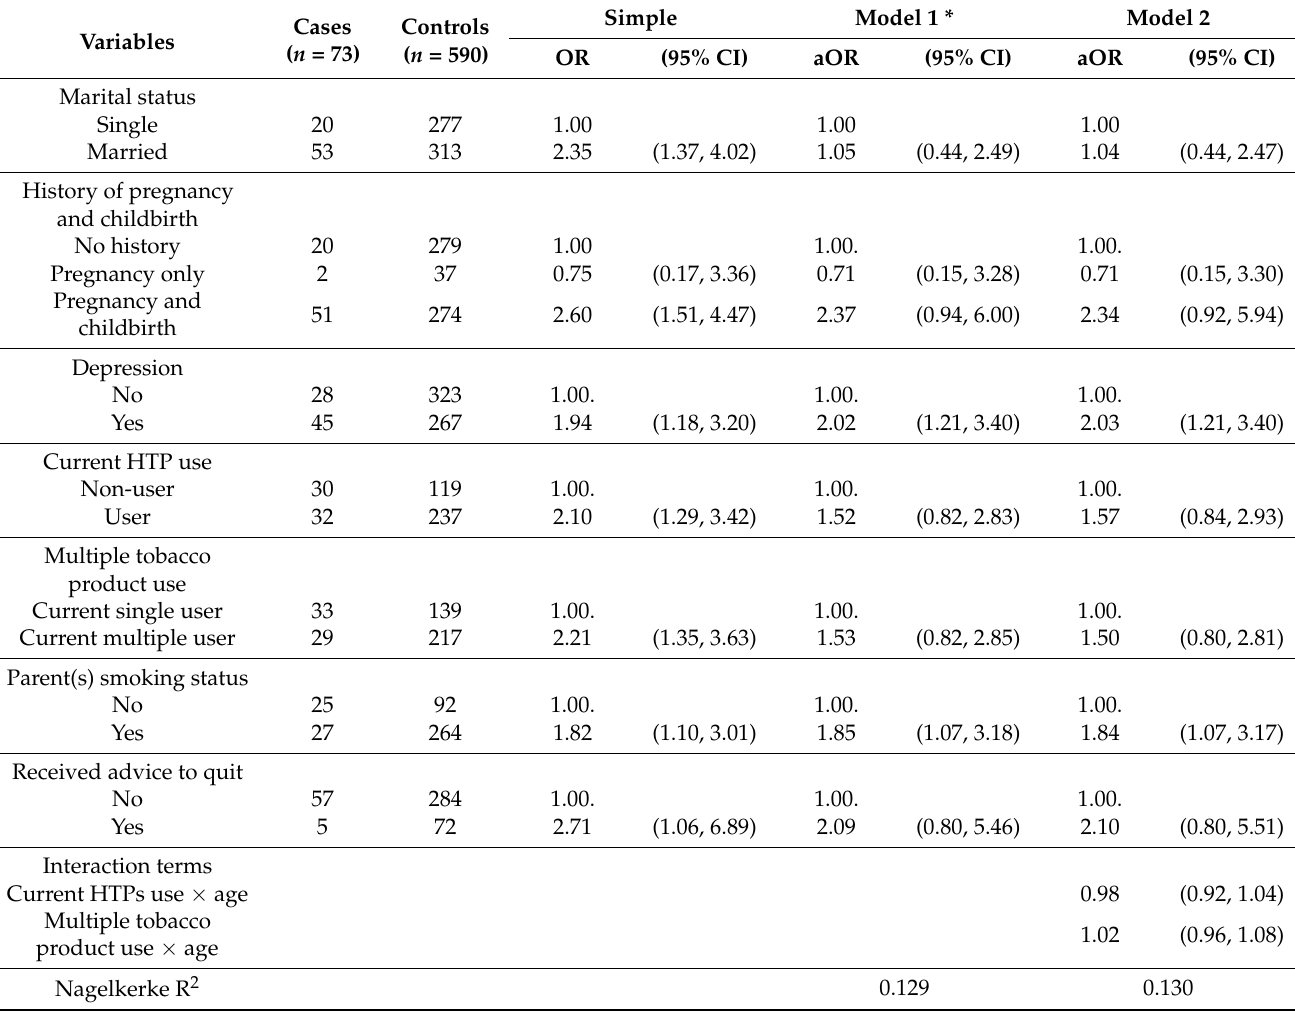
Table 2. Simple and multiple regression analyses of factors associated with the utilization of national tobacco cessation services ( n =